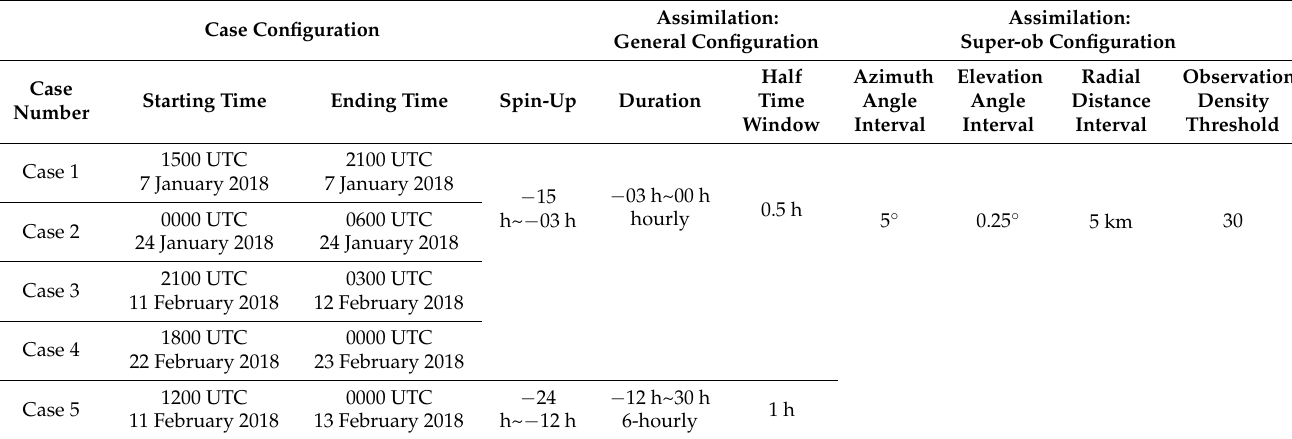
Table 1. Durations of different cases and configurations of radar data assimilation.